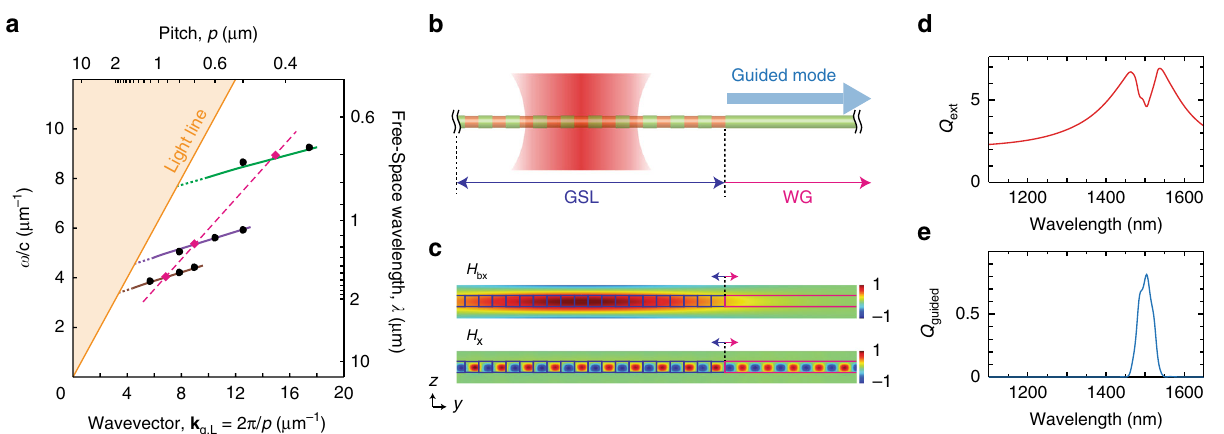
Fig. 3 Selective excitation of guided modes through a NW GSL. a Dispersion curves (solid lines) of fundamental HE 11 guided modes in in fi nitely long NWs with d = 140 nm (green), d = 250nm (purple), and d = 340 nm (brown). Marker symbols denote the positions of scattering dark states that are centered on a Mie resonance (magenta diamonds) or off-center from a Mie resonance (black circles). Magenta dashed line represents the frequency of a BGS that is centered on a Mie resonance for each value of d , so the intersection of solid and dashed lines represents the condition ω m = ω g . b Structure and excitation geometry of a NW GSL connected to a NW WG. c Calculated magnetic fi eld pro fi les of an incoming Gaussian beam background fi eld, H bx , (top) and an excited mode scattered fi eld, H x , (bottom) of a NW GSL with d = 330 nm, e = 310 nm and p = 900 nm, and 10 periods, showing propagation from the GSL into the WG. d , e Simulated Q ext ( d ) and Q guided ( e ) spectra corresponding to the structure in b and